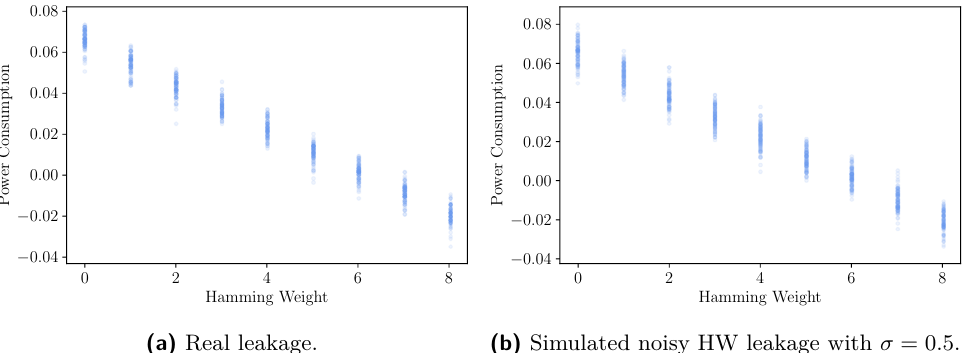
Figure 2: Real/simulated leakage of a STR instruction on an 8-bit XMEGA 128D4 micro- processor. The value range of the simulated leakage is scaled so that it coincides with the real